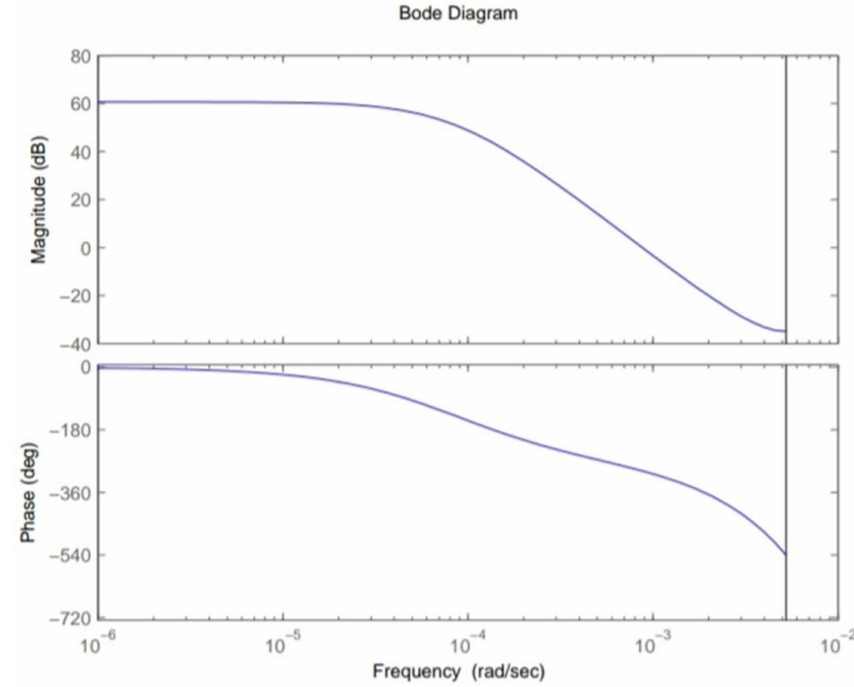
Figure 4. Bode plot of system.